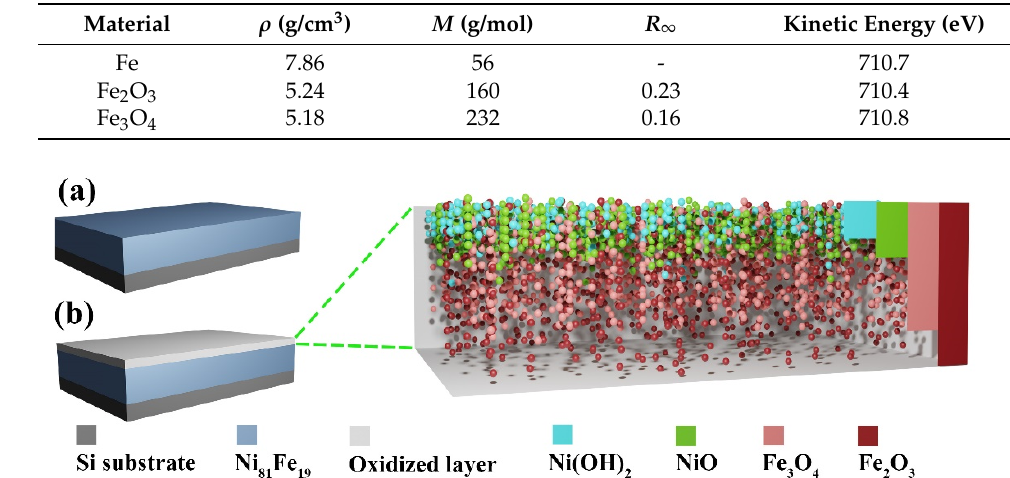
Table 4. The values of density, molecular weight, and kinetic energy for Fe, Fe 2 O 3 , and Fe 3 O 4 , as well as R ∞ for both iron oxides.